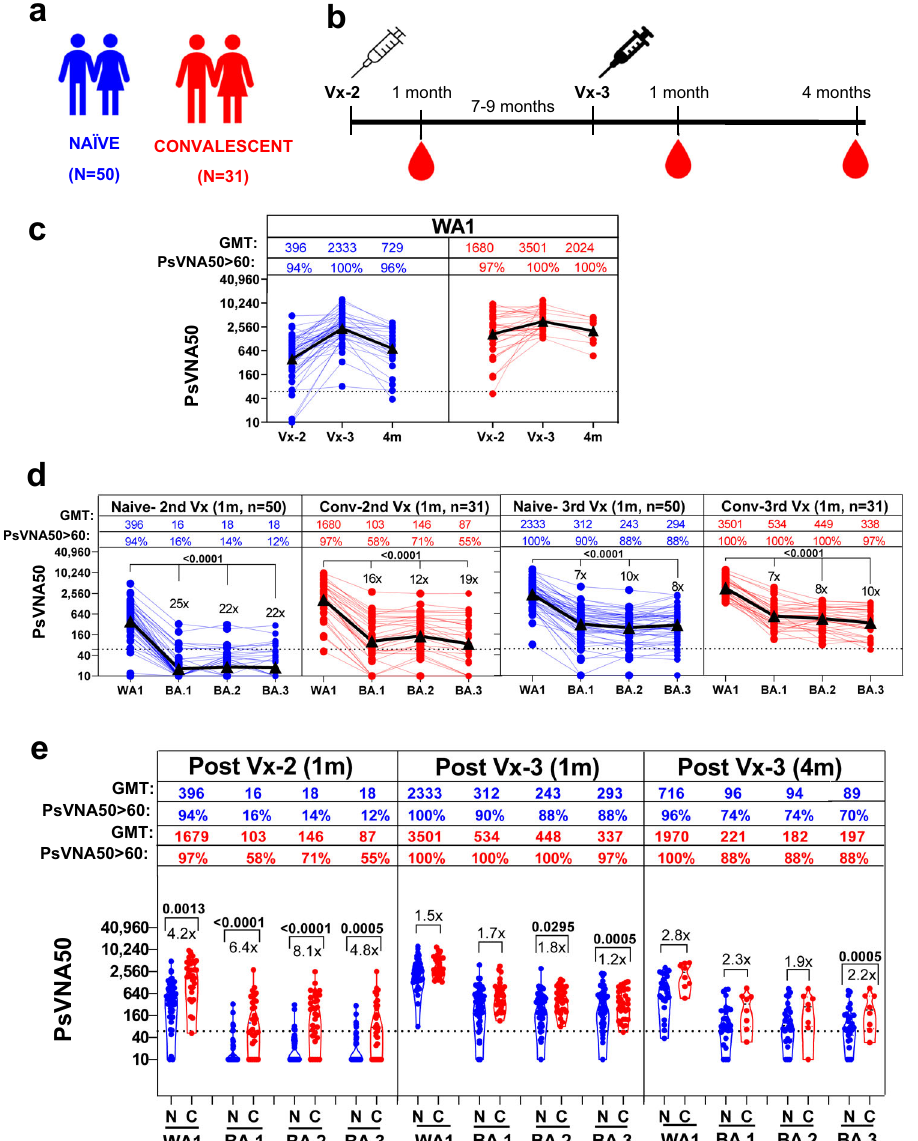
Fig. 1|Neutralizingantibodiesfollowing secondandthirdvaccinationinnaïve and convalescent adults against SARS-CoV-2 WA-1 and Omicron subvariants. a Overviewofvaccinationcohort,including 50unexposed naive(N;inblue)and31 COVID-19 convalescent (C; in red) adults receiving second and third mRNA vacci- nation. b Timeline of SARS-CoV-2 vaccination and sample collection in the two adult cohorts. c – e SARS-CoV-2 neutralizing antibody titers in naive (N; in blue) vaccinationandconvalescentadults(C;inred)onemonthafterthesecondorthird mRNA vaccination and four months post-3rd vaccination against SARS-CoV-2 WA1 and Omicron BA.1, BA.2 and BA.3. c PsVNA50 of post-2 nd (Vx-2) or at 1m and 4m post-third dose (Vx-3) against WA1. Geometric mean PsVNA50 titers (GMT) are shown as black triangles and are presented for each vaccination time-point on top of the panel. Each data point represents an individual sample (circles). The hor- izontal dashed line indicates the seropositive cut-off for the neutralization titers (PsVNA50 of 60). Percent seropositivity (%S) for each group was calculated as number of seropositive samples divided by total number of samples x 100 in the group (70 – 74%) at 4-months post-third vaccination (Supplementary Fig.S1andFig.1e).Itisimportanttonotethatafterthe3 rd vaccinedose, the neutralizing antibody responses against the vaccine homologous WA1 were not statistically different between the naïve vs. convalescent groups, while the difference between the responses to the highly transmissible Omicron subvariant BA.2 was statistically lower at